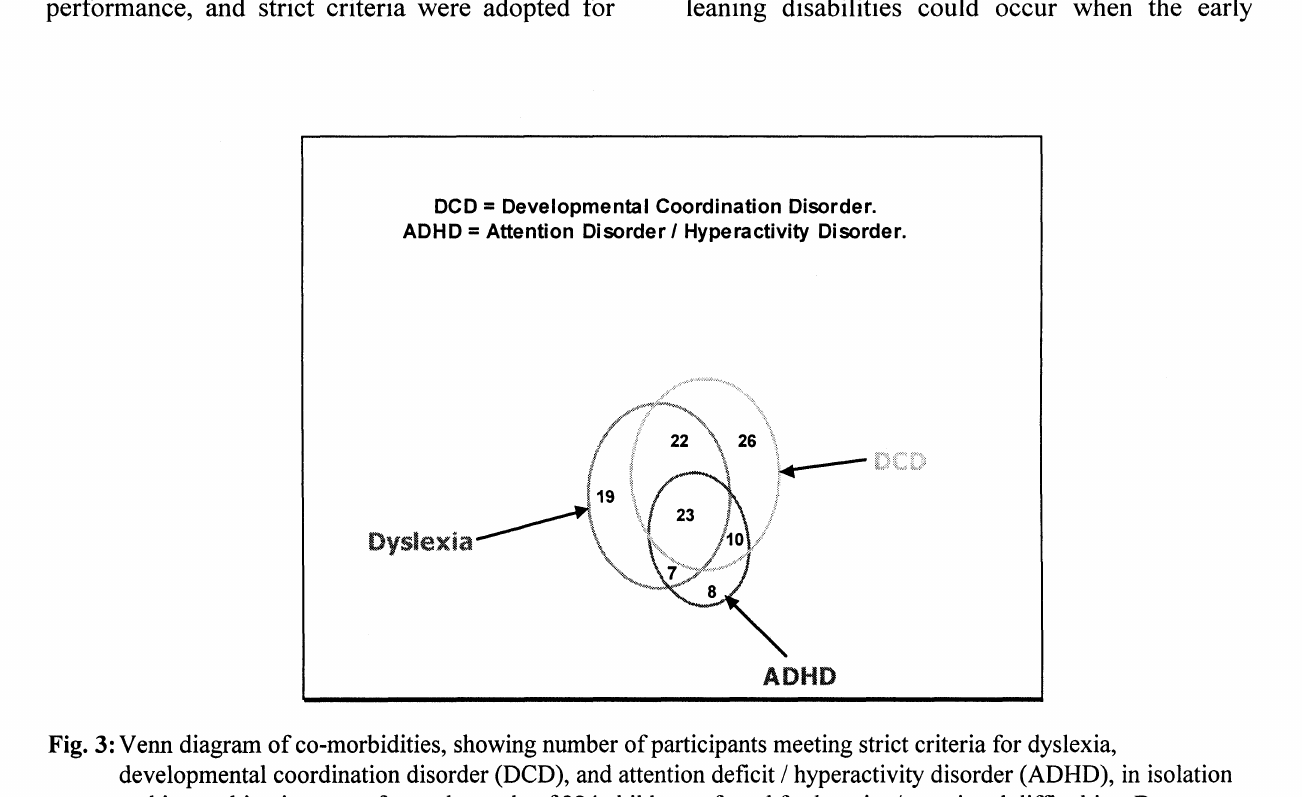
Fig. 3: Venn diagram of co-morbidities, showing number of participants meeting strict criteria for dyslexia, developmental coordination disorder (DCD), and attention deficit hyperactivity disorder (ADHD), in isolation and in combination, out of a total sample of 224 children referred for leaming/attentional difficulties. Data redrawn from Kaplan et al. 1998, with the permission of the